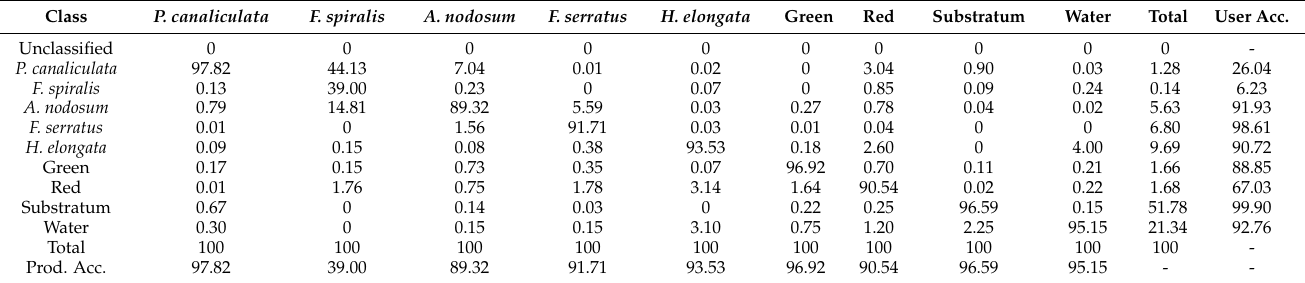
Table 4. Maximum likelihood classification (MLC) confusion matrix, calculated, using ENVI 5.6.1, by comparing pixels of known class locations to those predicted by the classification workflow for each of the nine cover classes. Results are displayed as percentages of pixels assigned, correctly or incorrectly, to each class. User/producer accuracies (User Acc. and Prod. Acc., respectively) are also